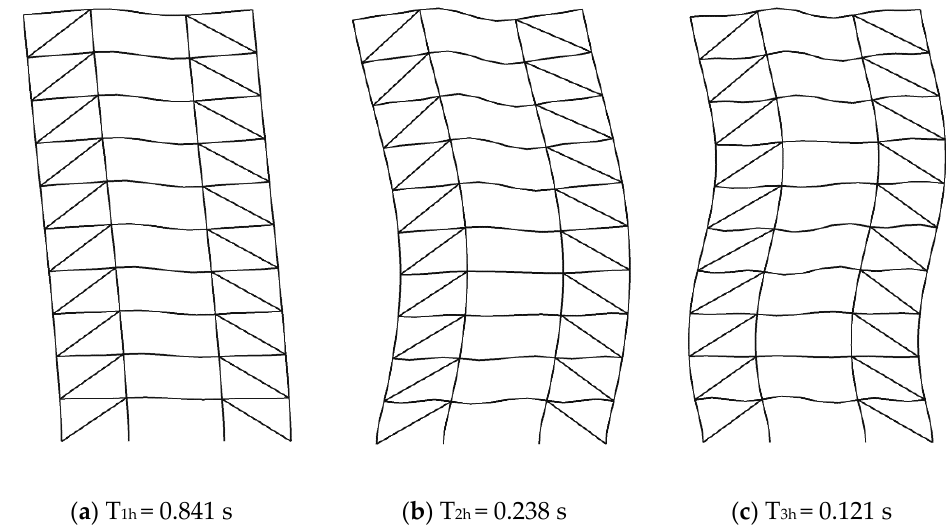
Figure 4. Horizontal vibration modes for the ten-story building.